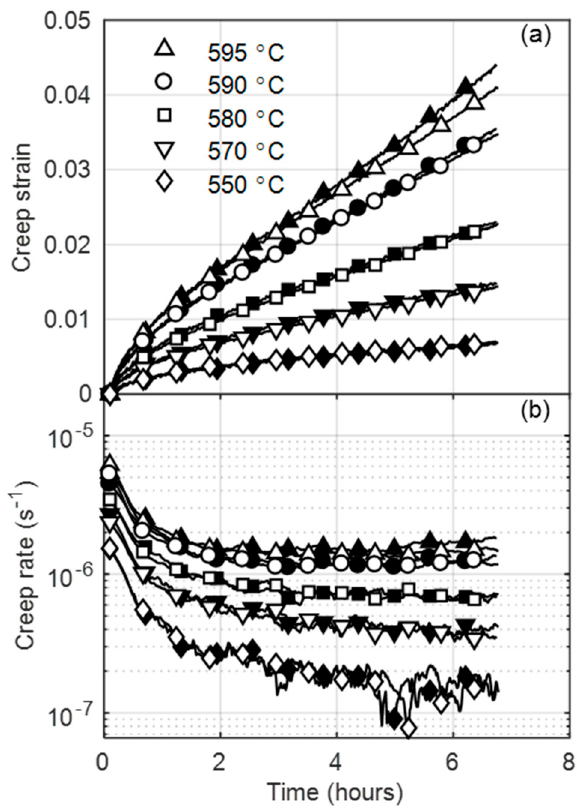
Figure 3. Evolution of accelerated ( a ) creep strain and ( b ) creep rate over time for two different (clear and shaded symbols) virgin X20 specimens at several temperatures.